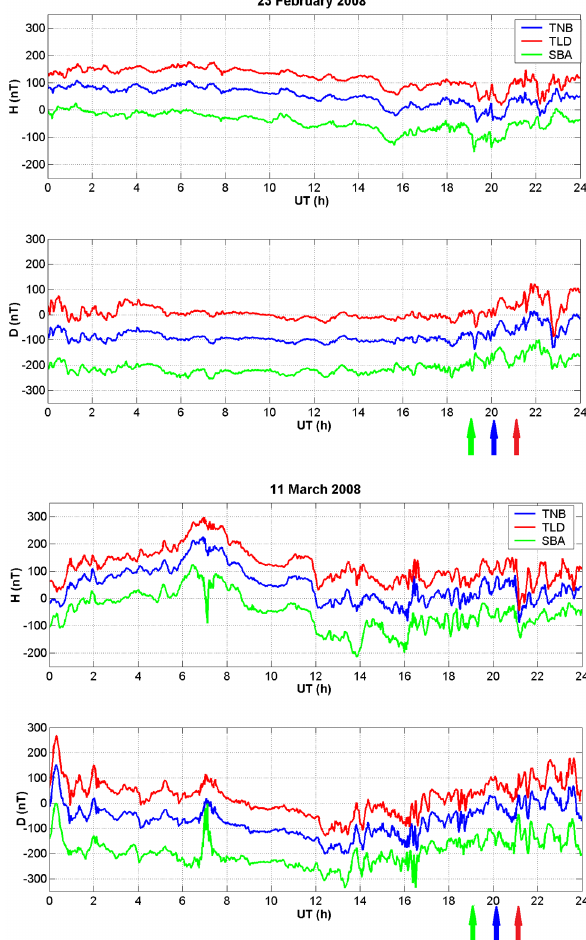
D at SBA, TNB and TLD. The arrows indicate MLT noon at the three stations. An arbitrary value has been added to each time series to show the variations in the same